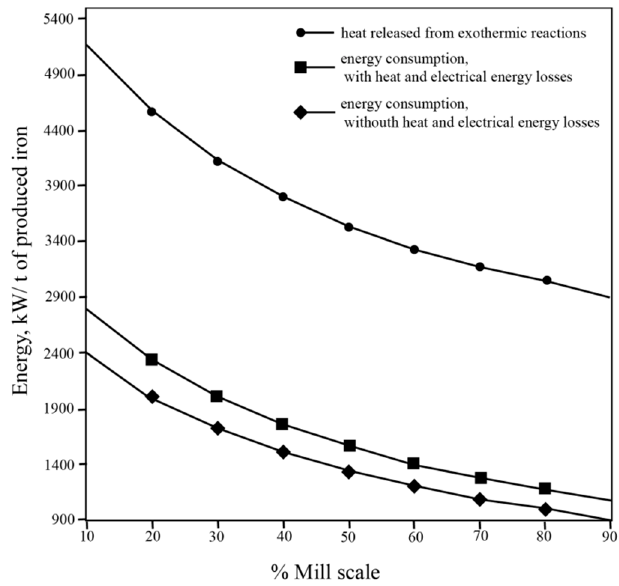
Figure 5. Energy consumption during the reduction of the pellets.